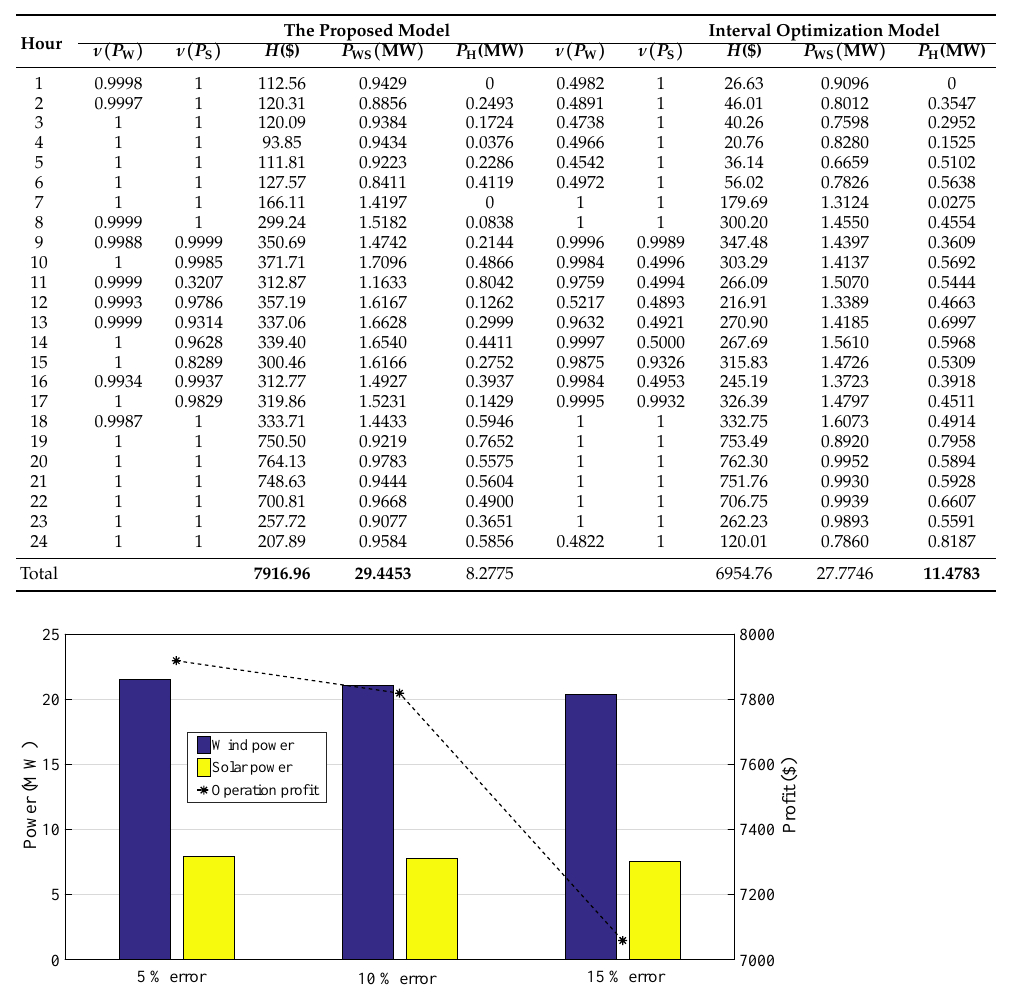
Table 5. Comparison results between CVaC and IO model.